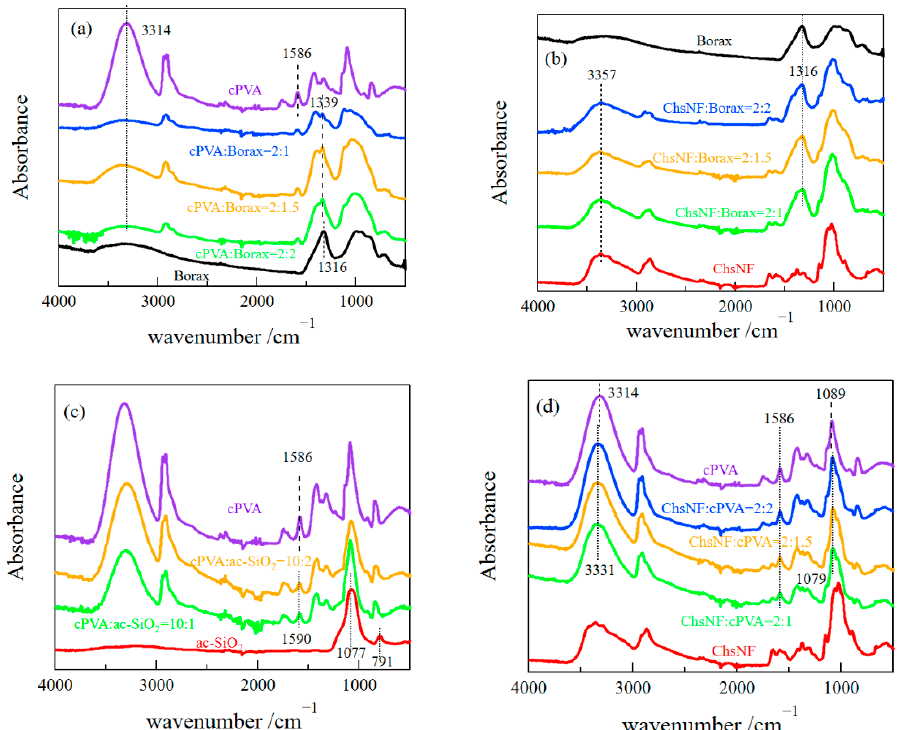
Figure 4. FT-IR spectra for cPVA/borax ( a ), ChsNF/borax ( b ), cPVA/ac-SiO 2 ( c ), and ChsNF/cPVA ( d ).